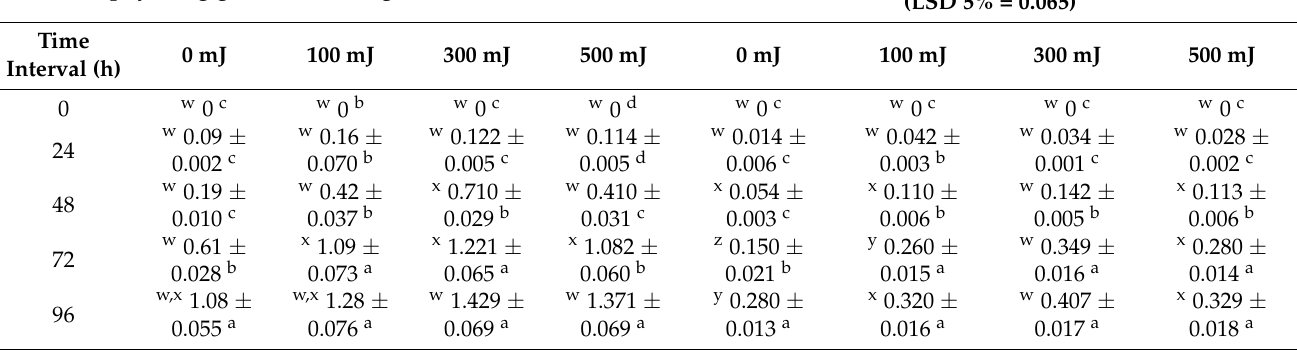
Table 2. Seed/seedlings chlorophyll, carotenoids, total soluble sugars and reducing sugar contents at different time intervals during germination when grown after irradiation with different doses of He–Ne laser (mean ± SE; n = 4). Chlorophyll (mg/g of Germinating Seeds) (LSD 5% = 0.25)